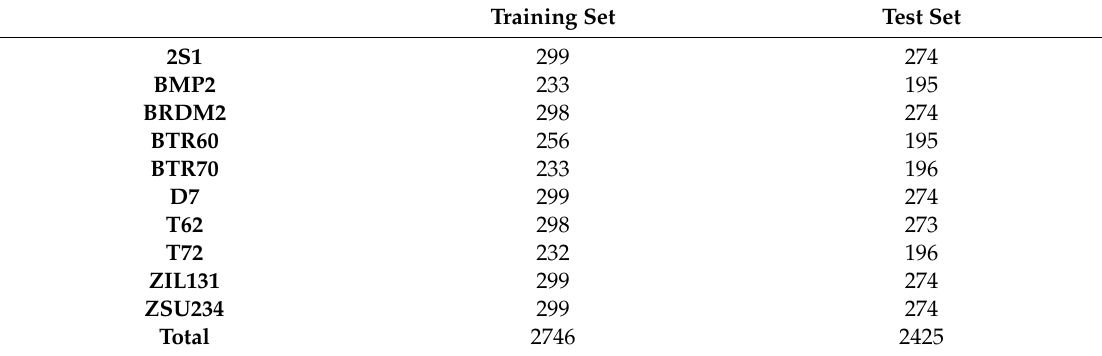
Figure 9. Ten classes of ground military targets’ optical and synthetic aperture radar (SAR) images. Table 2. Ten classes of moving and stationary target acquisition and recognition (MSTAR) targets and their sample numbers.